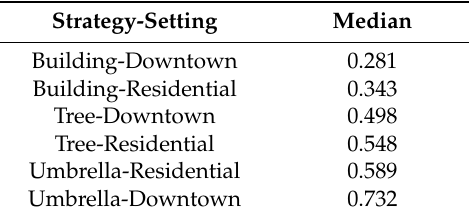
Table 3. Median COMFA ratio values for each of the strategy-settings; the strategy-settings are listed from most effective (lowest ratio) to least